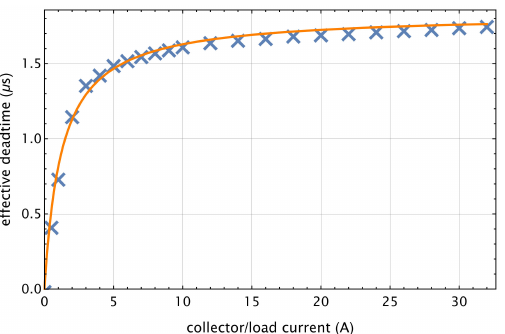
Figure 2. Measured (blue) and approximated (orange) dependence of the effective deadtime on the collector current; SEMIKRON SKM100GB12T4 IGBT module; actual deadtime 2 µ